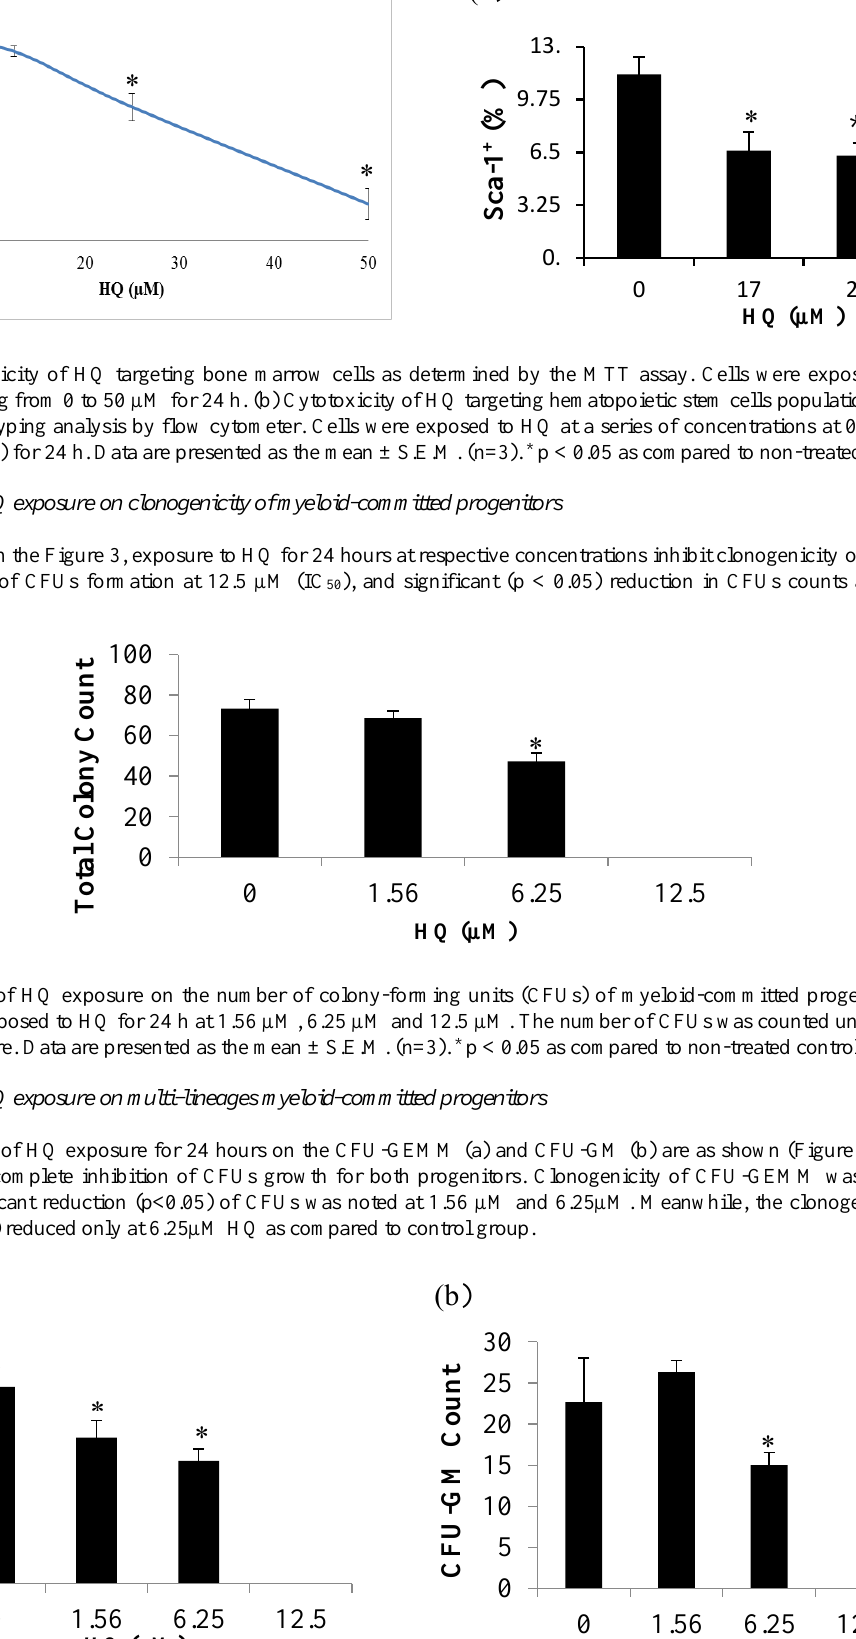
Figure 4 Effect of HQ on the clonogenicity of multi-lineages myeloid-committed progenitors was determined according to the colony counts of (a) CFU-granulocyte, erythroid, macrophage and megakaryocyte (CFU-GEMM) and (b) CFU-granulocyte and macrophage (CFU-GM). The mouse bone marrow cells were exposed to HQ for 24 h at 1.56 µM, 6.25 µM and 12.5 µM. The number of CFUs was counted and classified morphologically under inverted microscope after 14 days of culture. Data are presented as the mean ± S.E.M. (n=3). * p < 0.05 as compared to non-treated control